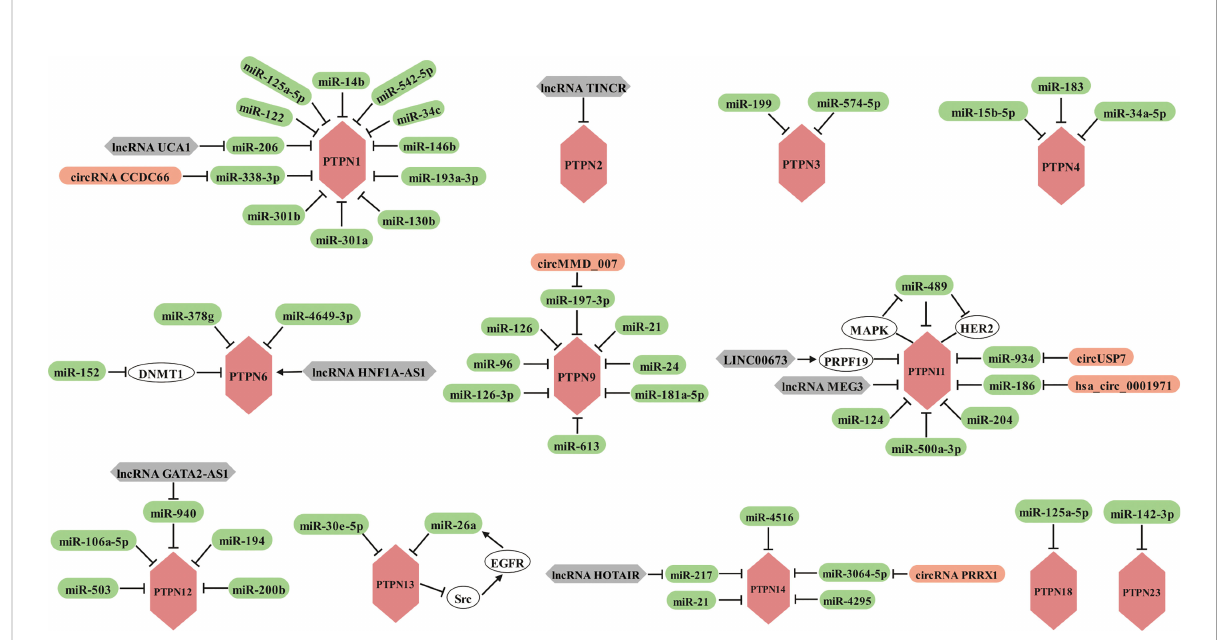
FIGURE 4 Members of the PTPN family are regulated by miRNAs, lncRNAs and circRNAs in various